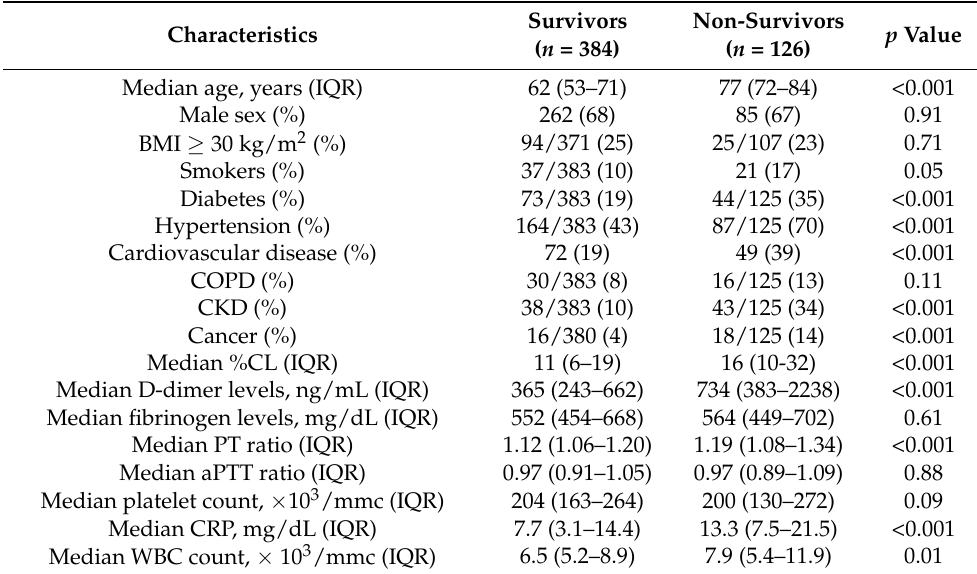
Table 2. Clinical and laboratory features of 510 consecutive patients with COVID-19 pneumonia included in the study and compared according to survival